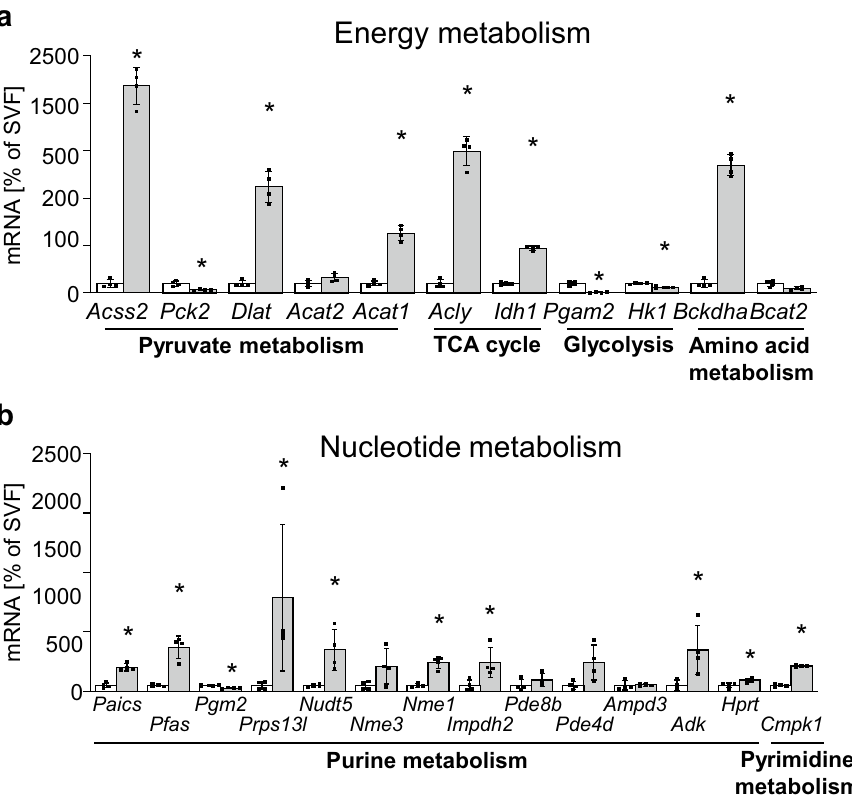
Figure 6. Expression of marker genes is enriched in mature adipocyte fraction. ( a ) mRNA levels of nutrient/ energy metabolism genes and of nucleotide metabolism genes ( b ) assessed in SVF (white bars) and mature adipocytes (grey bars) isolated from BAT of 2.5-months old mice. Genes (see Suppl. Table S5 for full gene names) are organized according to pathway enrichment in the proteome analysis of the same age groups (Table 1). For each gene, data are expressed as percentage of BAT-derived SVF. Data are shown as mean ± SD (n = 4 for all groups); *p < 0.05; assessed using non-parametric Mann–Whitney